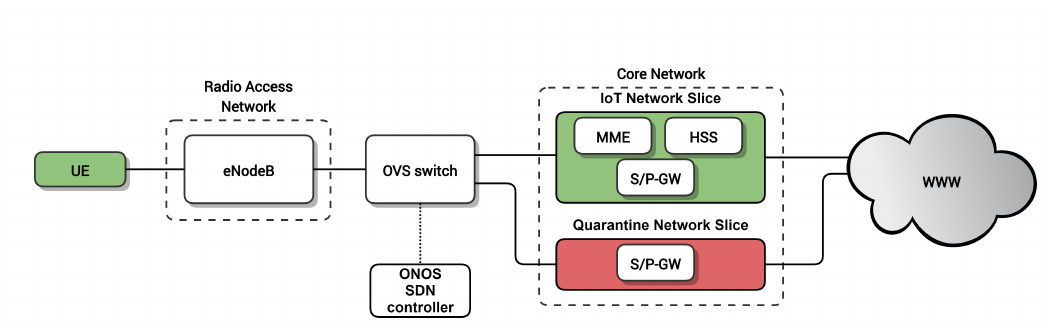
Figure 6. Architecture of the setup used for the